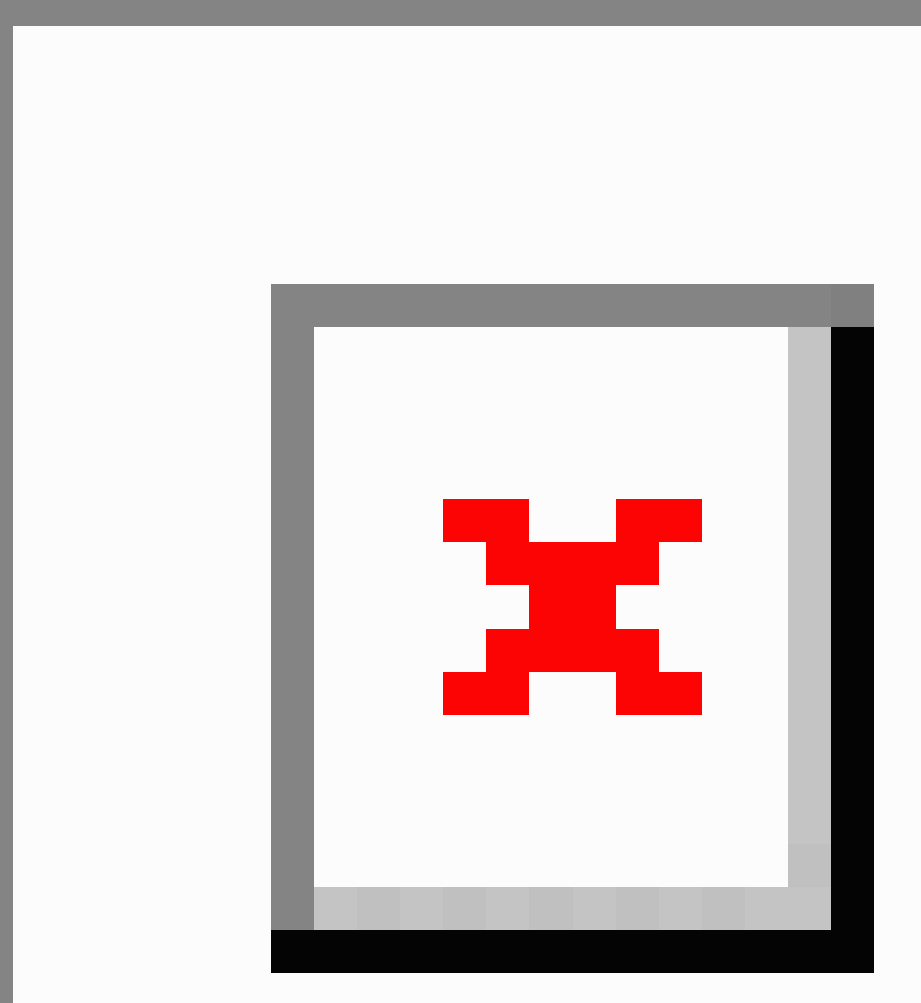
Figure 2. Examples of the ChemProt corpus. CPI: chemical-protein